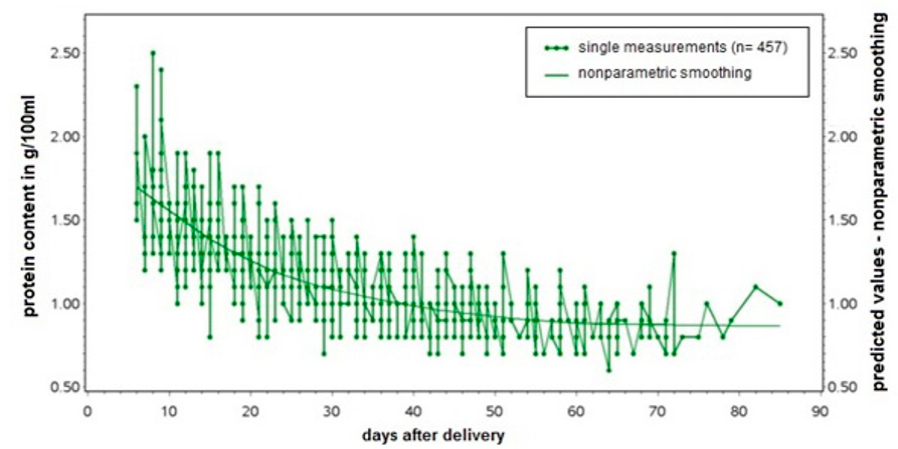
Figure 1. The breast milk-equation (BME): Protein content [in g/100 mL] = 6.755/day after delivery + 0.852.